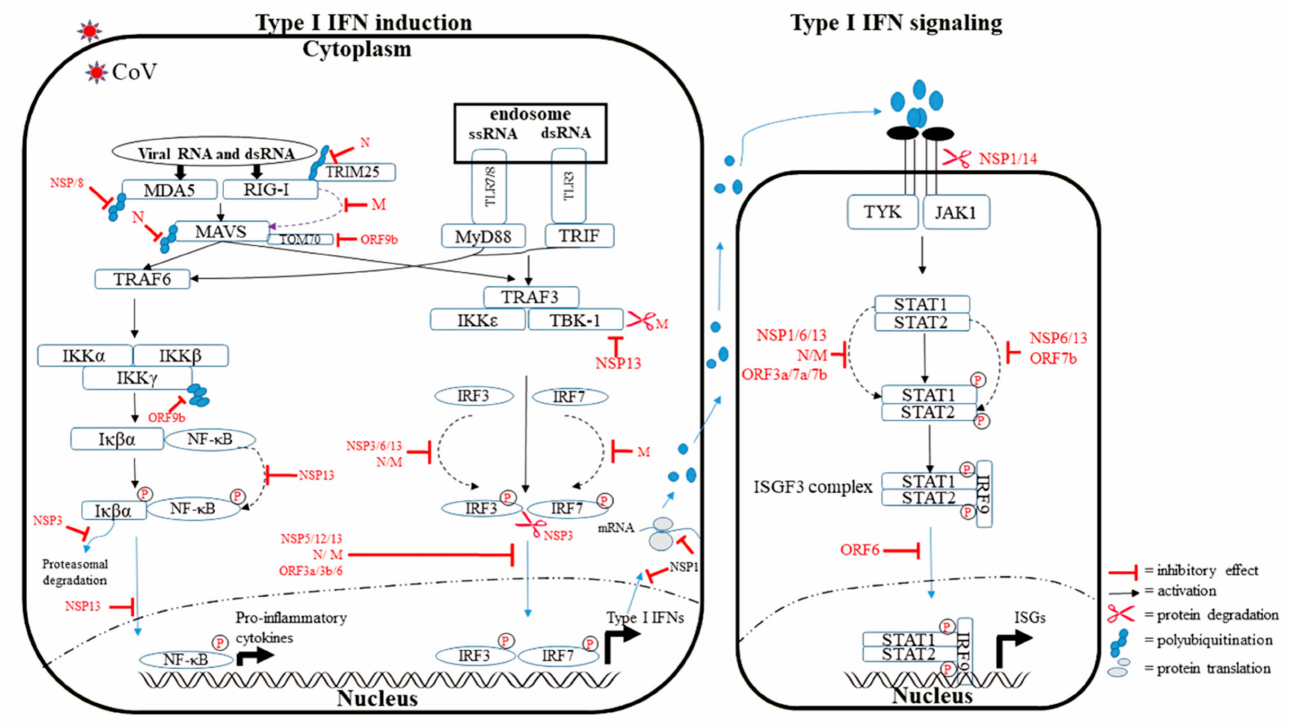
Figure 2. Type I IFN production and signaling pathway suppressed by SARS-CoV-2: Upon viral infection, the recognition by host innate immune sensors such as RLRs and TLRs triggers an antiviral signaling cascade, resulting in the production of IFNs and the activation of IFN signaling pathways, eventually ensuing in the production of ISGs. In contrast, SARS-CoV-2 has developed strategies to counteract the host defense system by inhibiting protein–protein interactions (dotted purple lines), the phosphorylation of proteins (dotted black lines), degrading of host cellular proteins (scissors), and cellular localization of proteins (blue arrowed lines). DMV: double-membrane